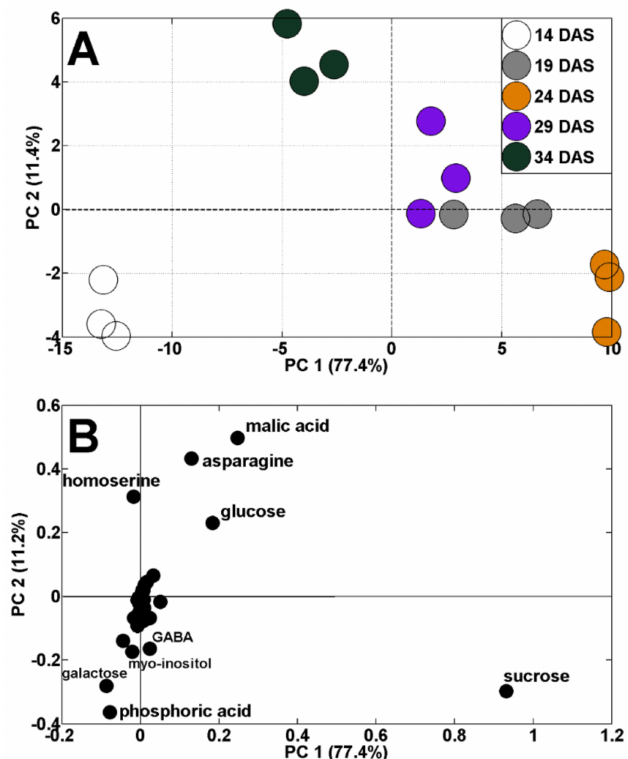
Figure 3. PCA of metabolite profiles of pea shoots during plant’s vegetation (14–34 DAS) at control conditions ( A ) and PCA loadings plots of polar metabolites ( B